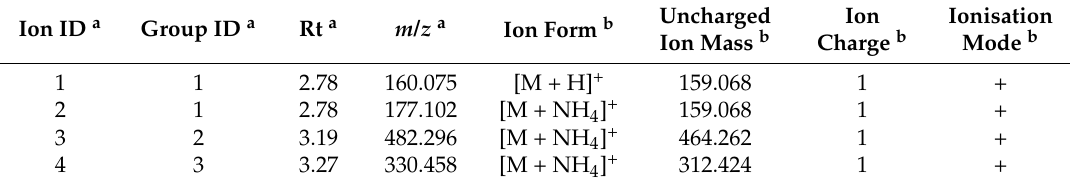
Table 1. Structure of a typical reference feature list. Each feature is specified by four required values and four optional values relating to its ion species. “Ion ID” is an integer that uniquely identifies a feature. Each feature belongs to a feature group (i.e., metabolite), which is specified in the column “Group ID”. All features with the same “Group ID” are different ions of the same metabolite. “Rt” is the retention time of the feature in minutes and “ m / z ” is its mass-to-charge ratio. The remaining columns are optional and used for the generation of differently formed ions if